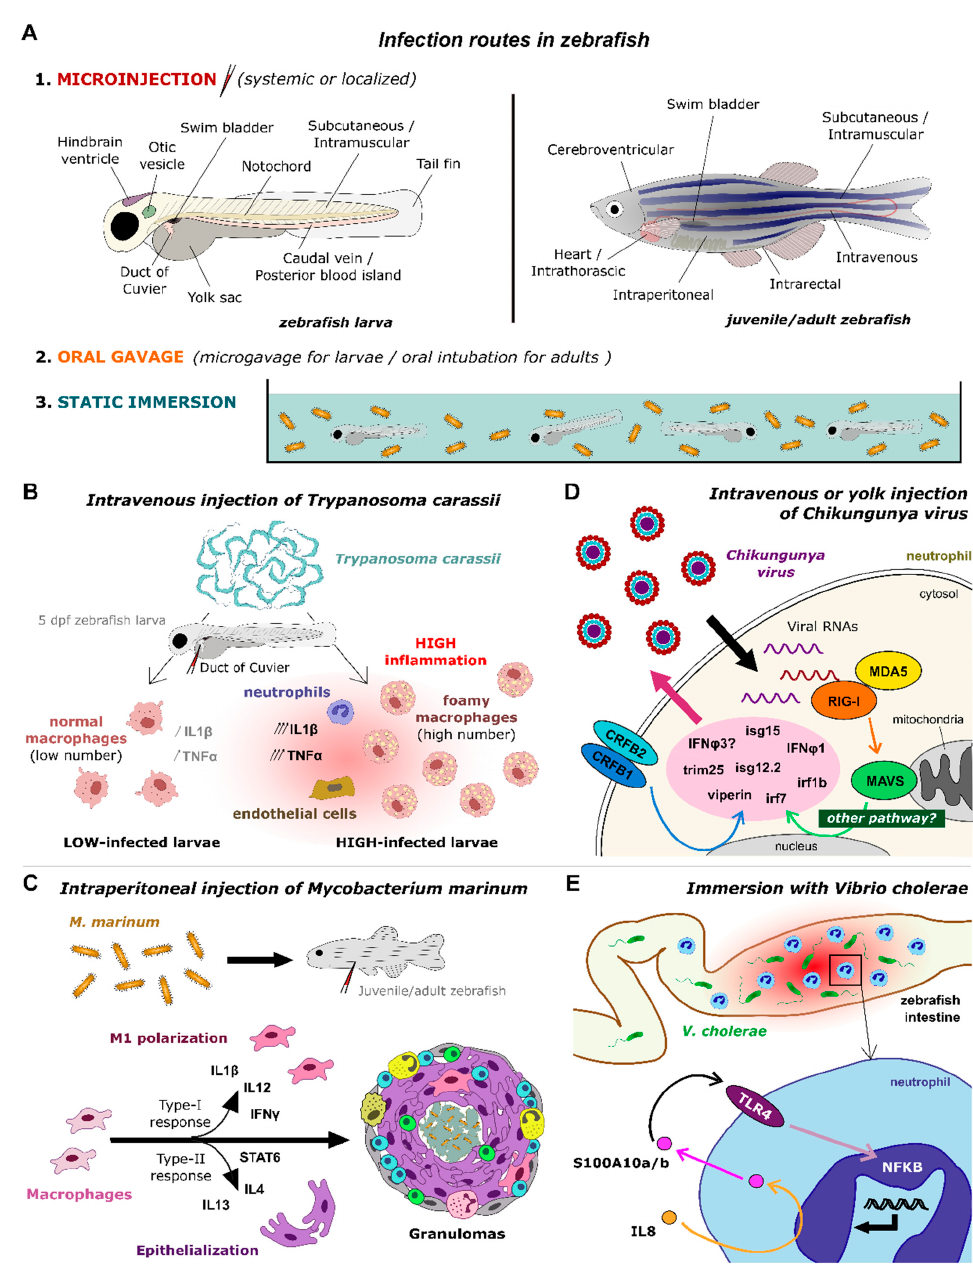
Figure 4. Signaling pathways unraveled by infection models in zebrafish. ( A ). Infection routes used in zebrafish models include micro-injection in various organs/tissues, oral gavage, and immersion of the pathogens in the fish water, both for larvae and adult zebrafish. ( B ). A model of infection by Trypanosoma carassii through intravenous injection in 5 dpf larvae revealed two distinct macrophage pro-inflammatory phenotypes depending on the level of infection, high-infected larvae producing foamy macrophages with strong pro-inflammatory response and incapacity to control the para- sitemia [199]. ( C ) . A model of infection by Mycobacterium marinum through intraperitoneal injection in juvenile or adult zebrafish showed that both M1- and M2-type macrophage responses are needed for mycobacterial pathogenesis and formation of granulomas [338]. ( D ). A model of infection by Chikun- gunya virus through intravenous or yolk injection in larvae uncovered the interferon-dependent antiviral immune response elicited by neutrophils [77]. ( E ). An adult model of infection by Vibrio cholerae through immersion evidenced the NF κ B-dependent recruitment of leukocytes in the intestine through activation of an IL8/S100/TLR4 pathway